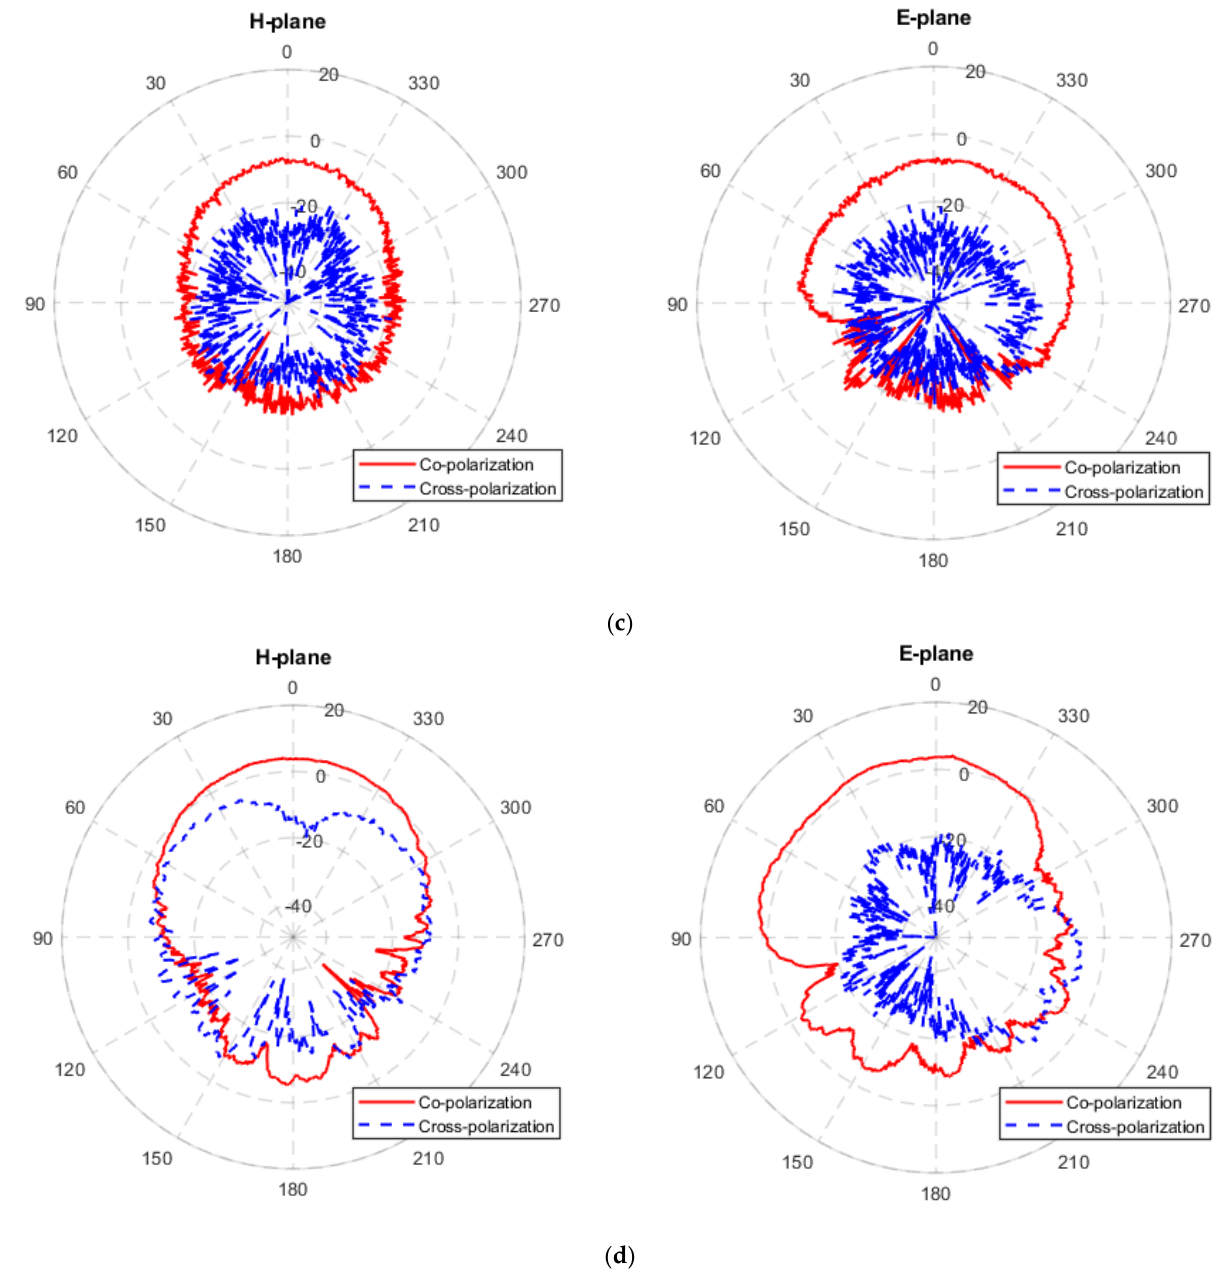
Figure 9. Measured H-plane and E-plane radiation pattern at center frequency. ( a ) Case 1. ( b ) Case 2. ( c ) Case 3. ( d ) Case 4. Red line: co-polarization; blue line: cross-polarization.